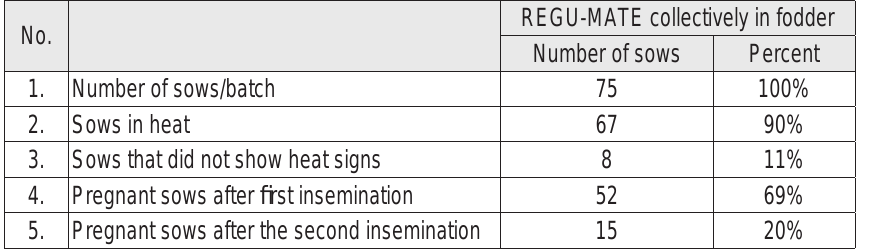
Table 1. Results obtained for batch 1